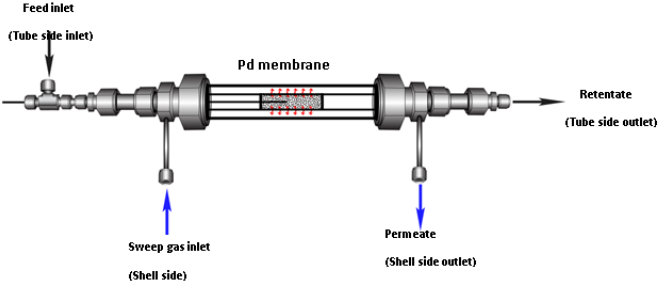
Figure 2. Pd multifunctional membrane reactor (MR) scheme.